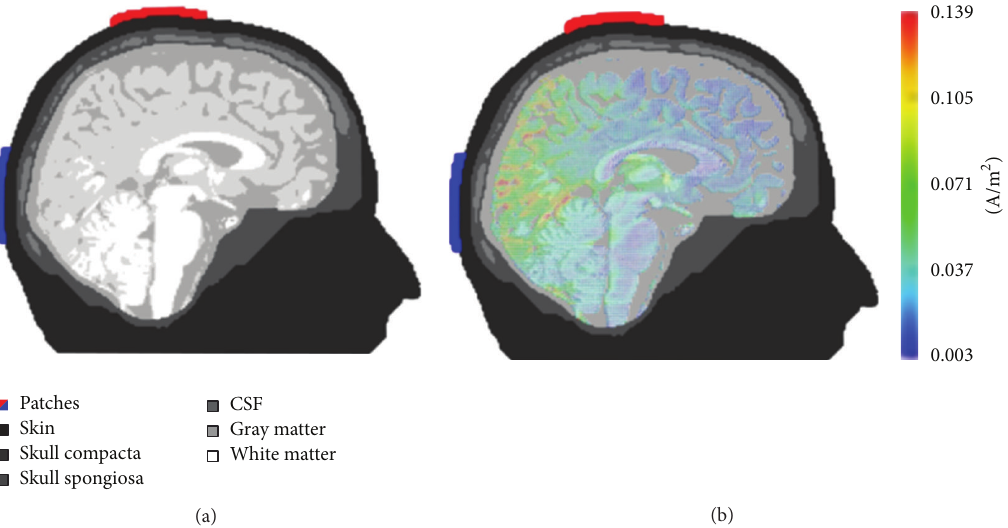
Figure 2: (a) Anisotropic finite element model for simulations of intracranial current flow. Stimulation electrodes are at the EEG electrode positions Cz and Oz of the international 10–20 system for electrode placement (red and blue, resp.). (b) Current density simulations reveal strongest current flow is in the posterior part of the brain underneath and between the stimulation electrodes. Reprinted with permission of the authors from